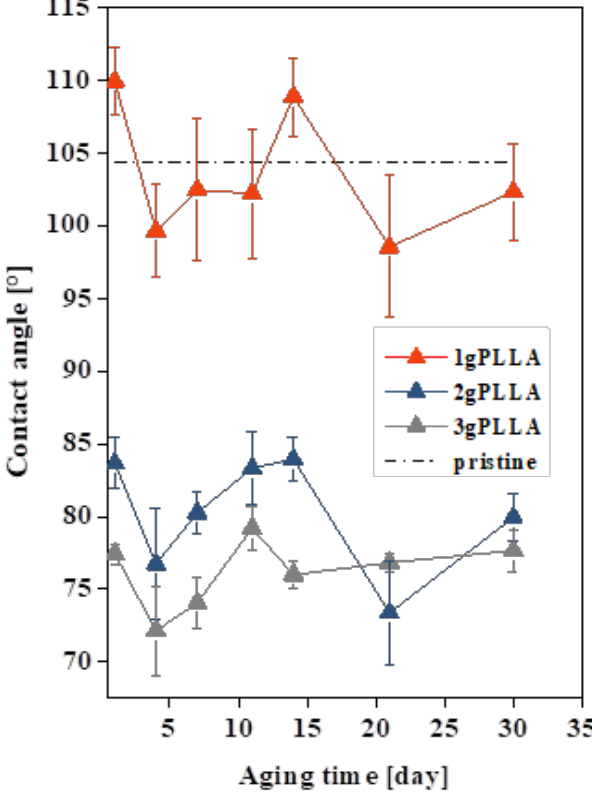
Figure 3. The contact angles and aging of unmodified FEP (pristine) and FEP foils modified at 8 W and 240 s and then immersed in polymer solution containing 1, 2, or 3 g of PLLA.